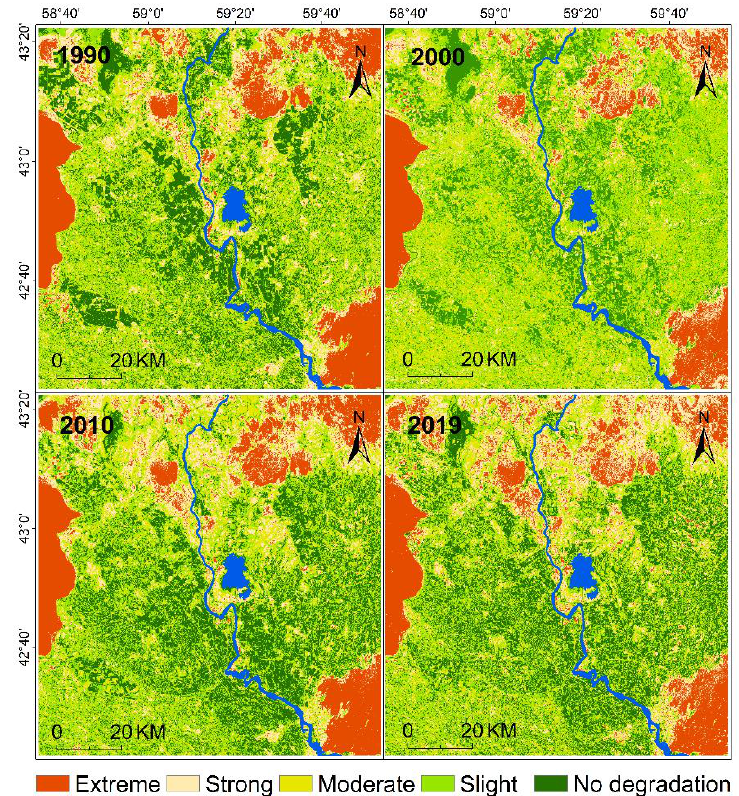
Figure 4. Spatial distribution of the land degradation levels in the ADD in each study year. Extreme: extreme degradation; Strong: strong degradation; Moderate: moderate degradation; Slight: slight degradation.